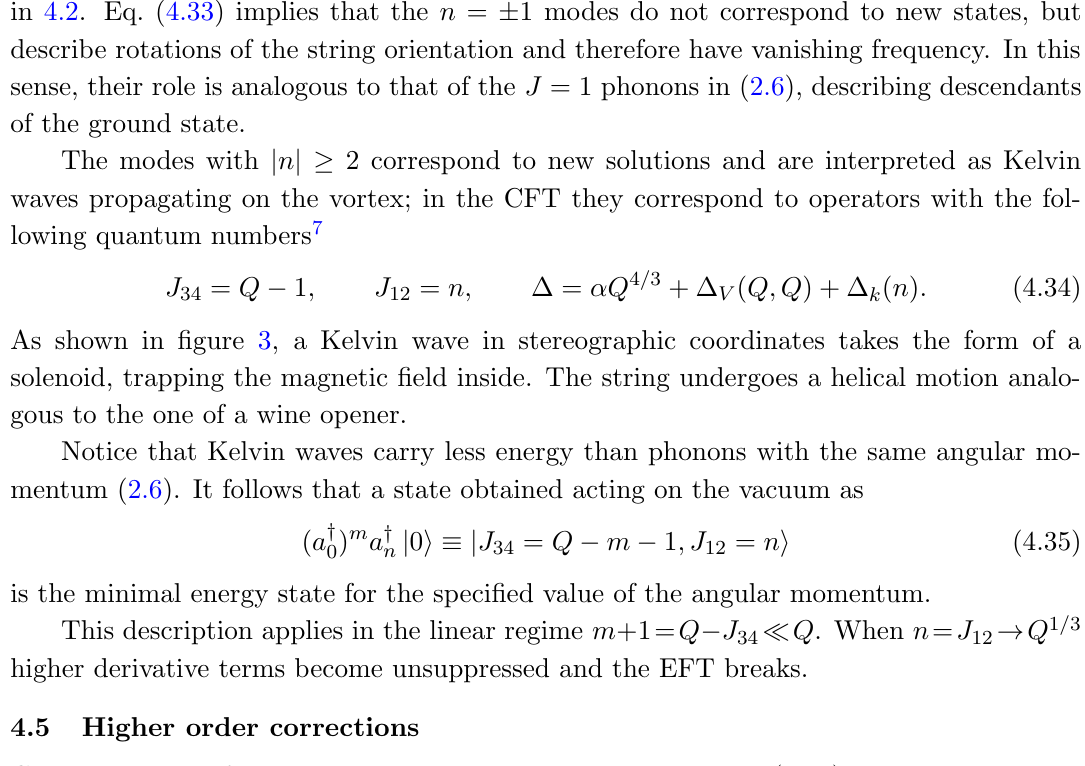
( X 3 ; X 4 ; X 2 1+ X 1